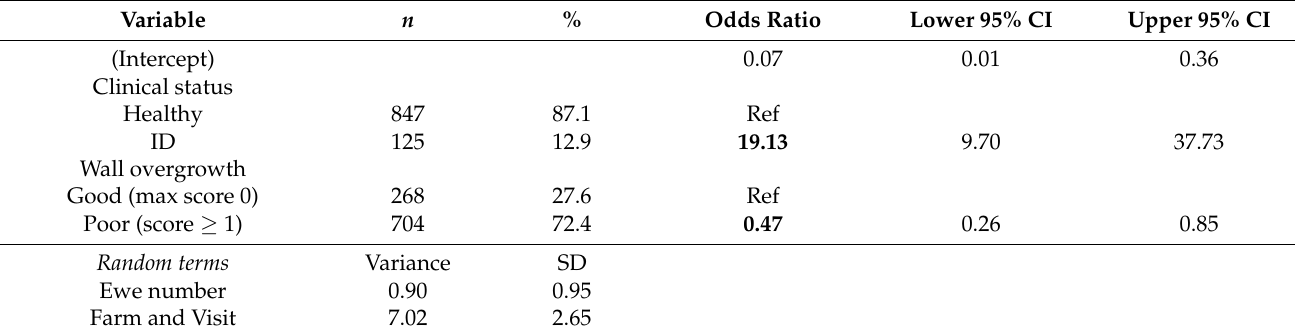
Table 9. Binomial mixed effects model of presence of Dichelobacter nodosus from 972 foot-level observations.